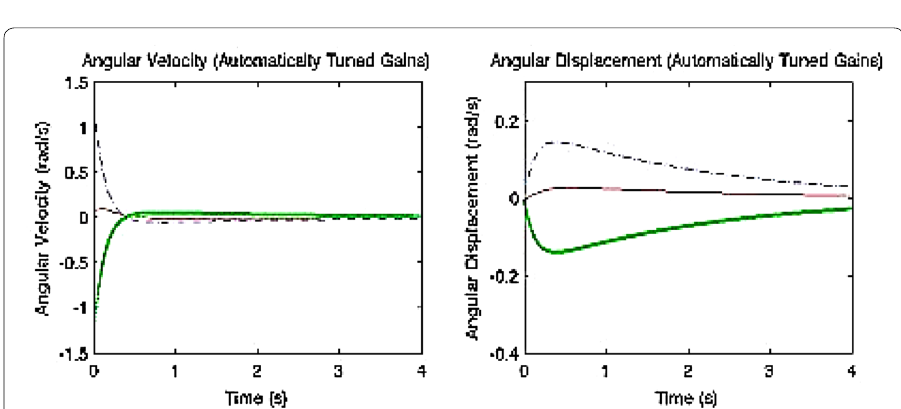
Fig. 5 Automatic generated graph of angular velocities and